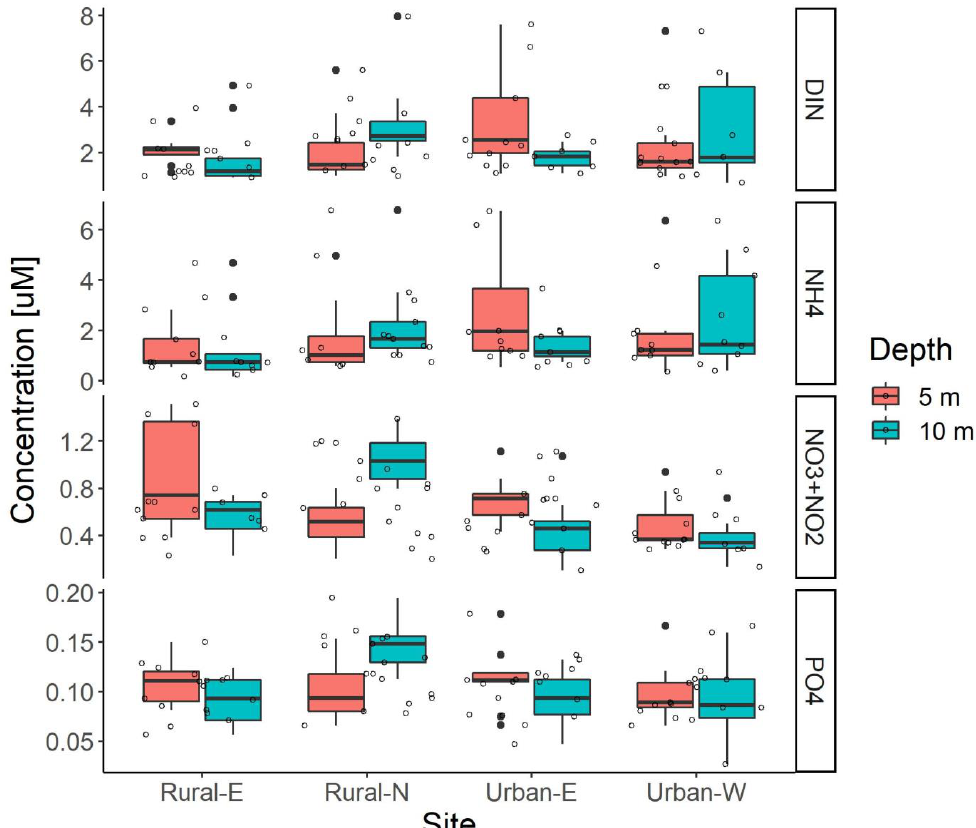
Figure 6. Seawater nutrient concentrations (top to bottom: dissolved inorganic nitrogen [DIN], NH 4+ , NO 3 − + NO 2 − , PO 43 − ) sampled in triplicate on each transect at the four sites (Urban-W, Urban-E, Rural-N, Rural-E), two depths (5 m and 10 m), and three transects per depth in Timor-Leste in November 2015. Bold line is the median, box ends are the first and third quartile, lines are 95% confidence interval of the median, and points are Tukey’s outliers. Gray points indicate samples. Note differences in scales. Stable isotope values were consistent across sites, with no elevated values at the ur- ban sites compared to the rural sites. Delta 15 N stable isotopes had a significant site differ- ence for both algae species. Urban-E had significantly lower δ 15 N in both algae species (Table 1).